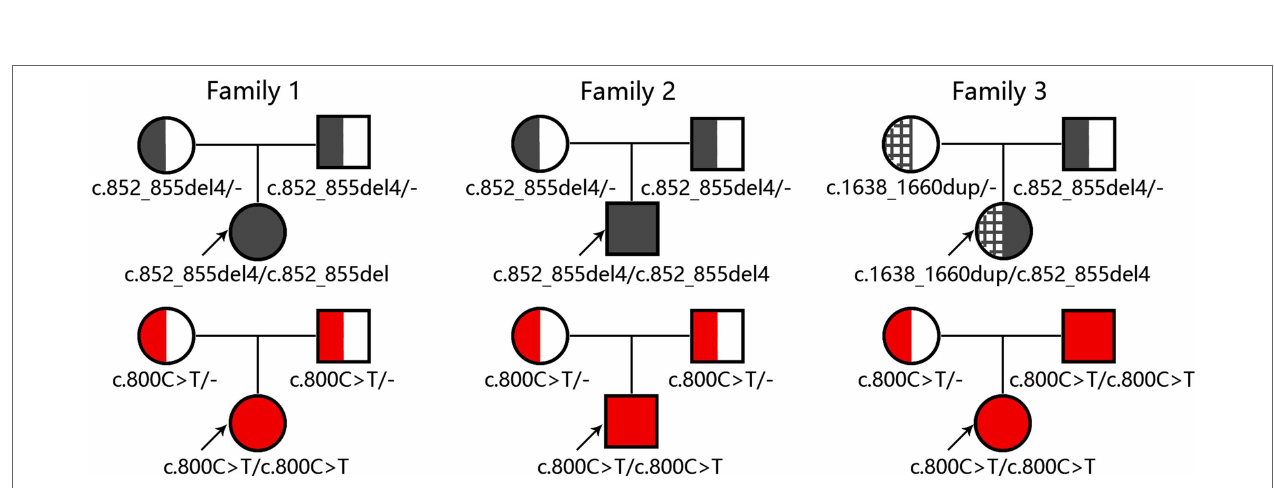
FIGURE 3 | Diagrams for family trees with the causative genes SLC25A13 and SLC10A1. The upper and lower panel illustrated the SLC25A13 and SLC10A1 genotyping findings in the three families, respectively.